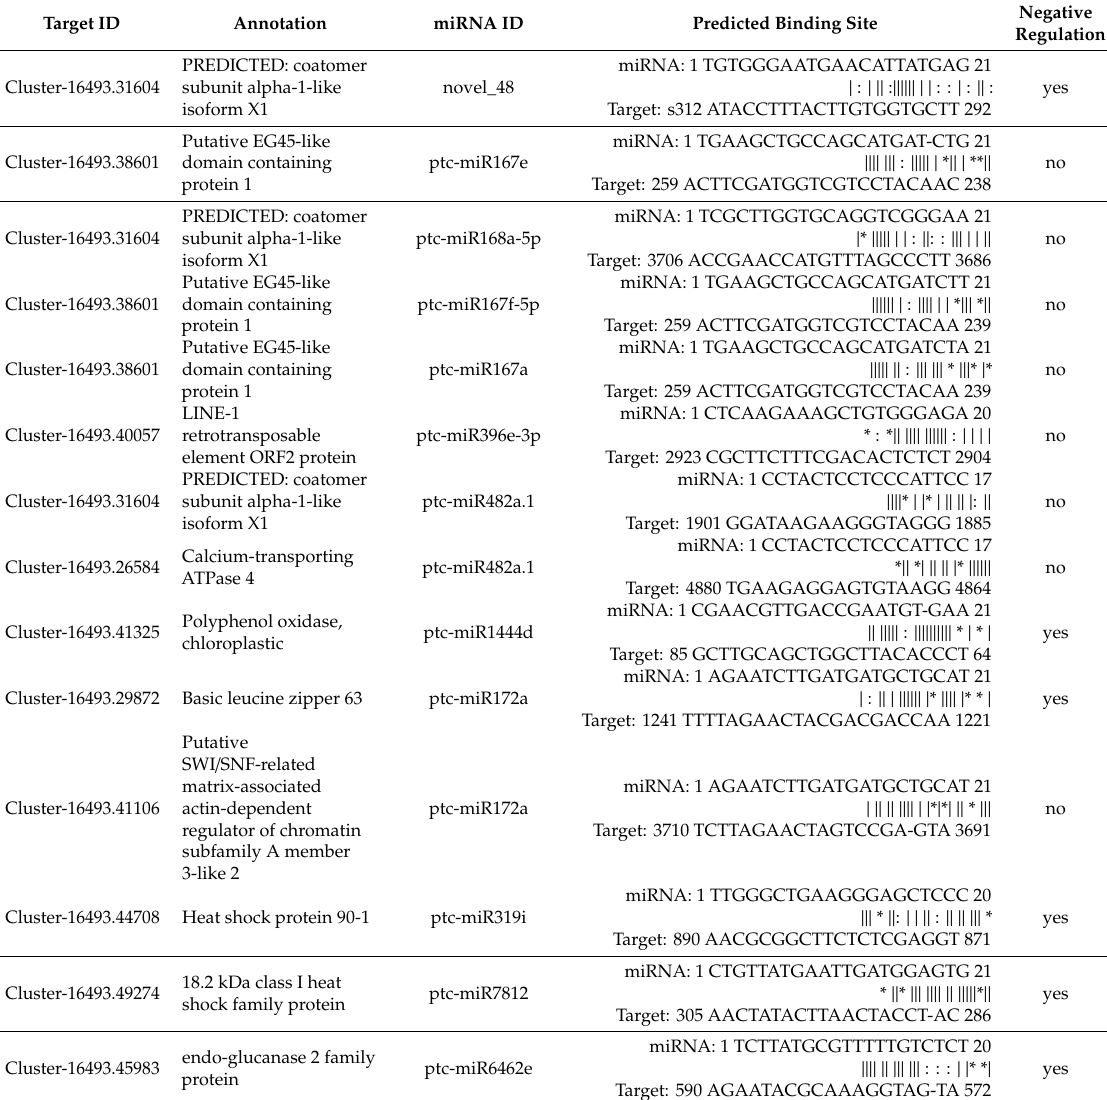
Table 3. The candidate di ff erential targets of cold-responsive miRNAs in Populus simonii × P.